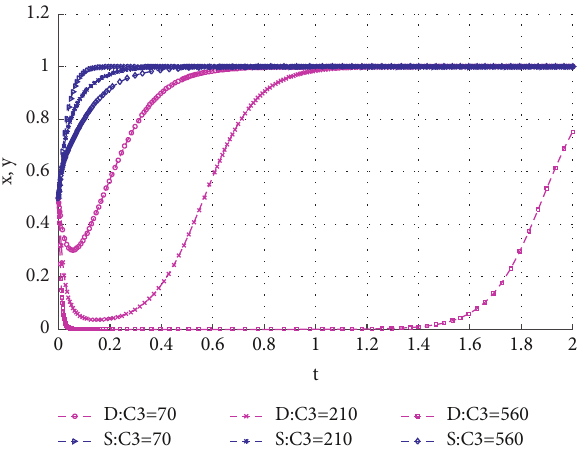
Figure 6: The evolutionary result of additional loss changes in opportunistic behavior.